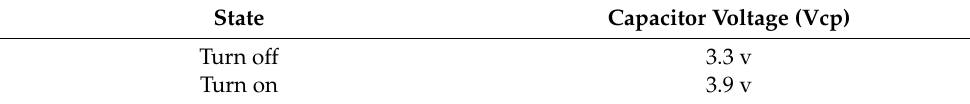
Table 2. Turn on-off voltages of the designed EHU.